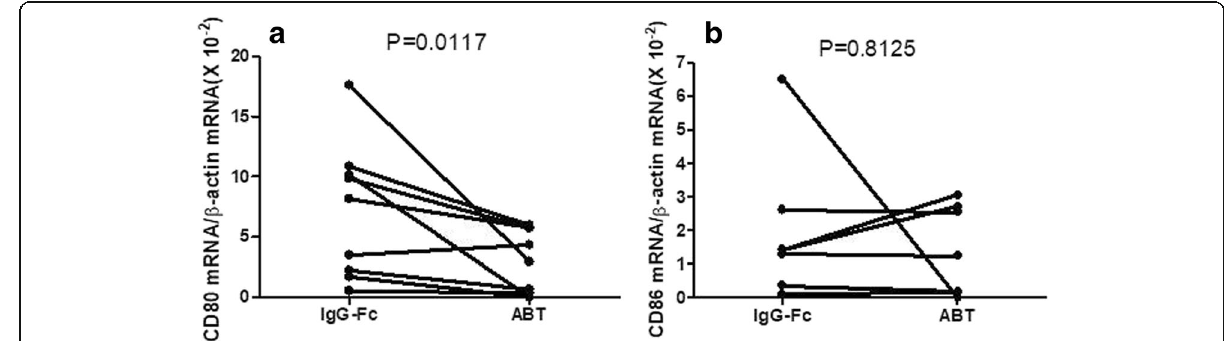
Fig. 4 Effects of abatacept on the mRNA expression for CD80 and CD86 of SEB-stimulated monocytes. Highly purified monocytes (1 × 10 6 /well) from healthy individuals were cultured in the presence of SEB (100 pg/ml) in each well of 24-well flat-bottomed microtiter plates with abatacept (100 μ g/ml) or control IgG-Fc (100 μ g/ml). After 24 h of incubation, the cells were harvested and the expression of mRNA for CD80 and CD86 were examined by quantitative RT-PCR. Data are expressed as the ratio to copy numbers of β -actin mRNA. Statistical significance was evaluated by Wilcoxon ’ s signed-rank test. CD80 ( a ) and CD86 ( b